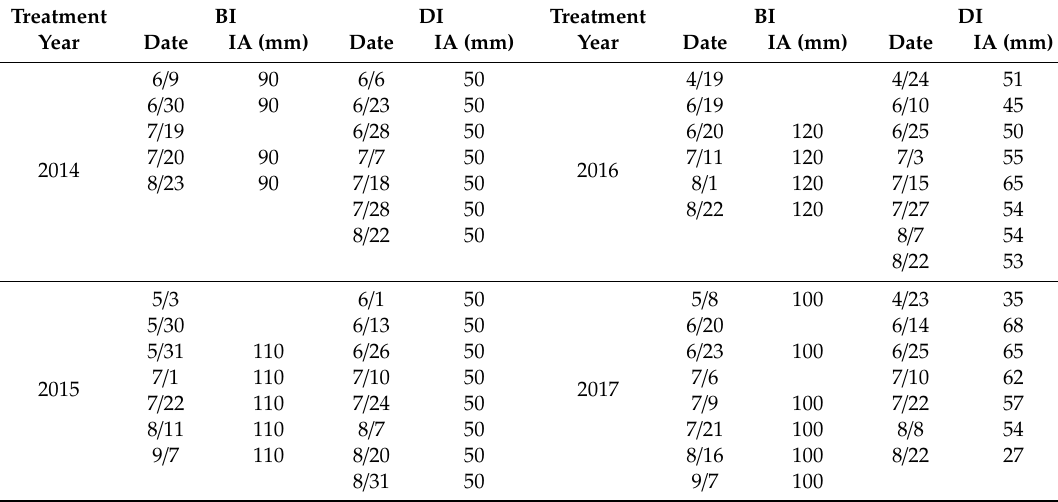
Table 1. The irrigation regime. IA is the irrigation amount; BI represents border irrigation; DI represents drip